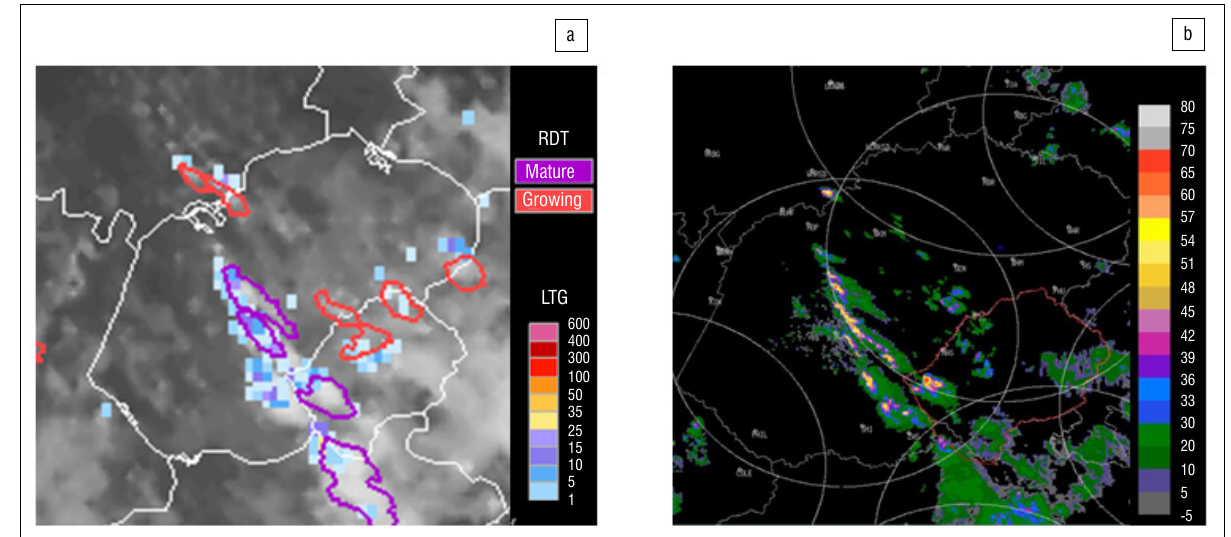
Figure 3: (a) RDT data at 12:30 UTC and lightning from 12:20 to 12:40 UTC and (b) radar reflectivity at 12:30 UTC on 23 June 2012 over the central part of South